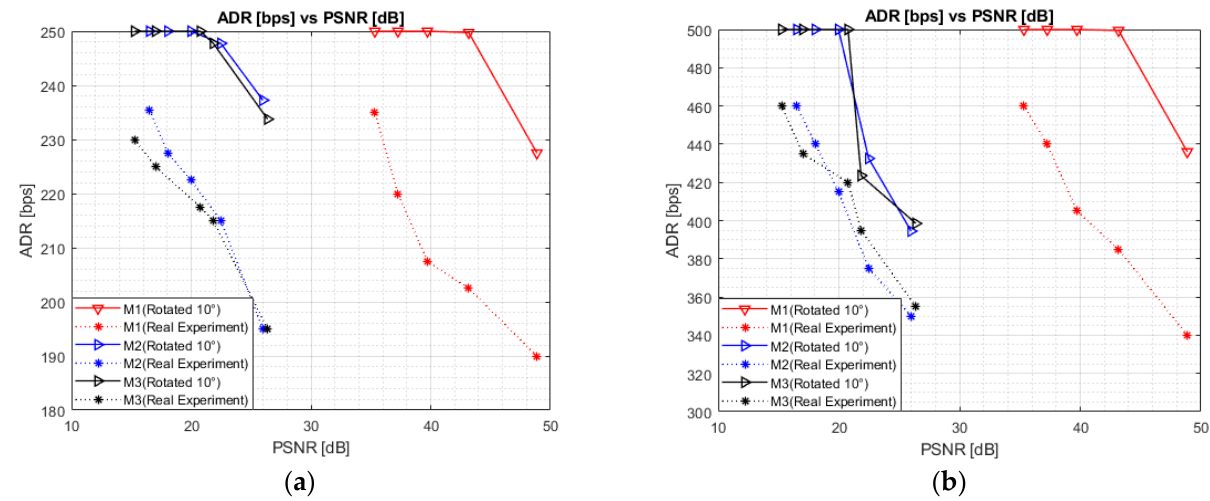
Figure 9. Achievable data rate (ADR) [bps] against the PSNR [dB] performance of the proposed system. ( a ) m = 250 and ( b ) m = 500.